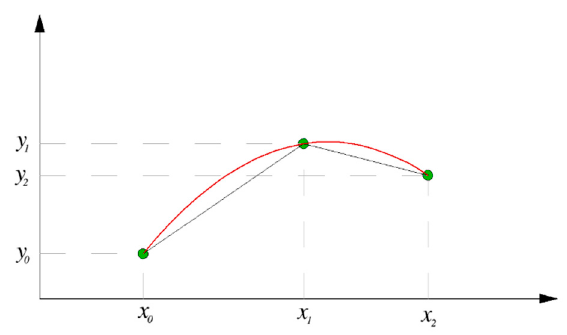
Figure 4. Lagrange interpolation by lines (black) and by a parabola (red). Inserting the values of the numerical example from Error! Reference source not found. into Error! Reference source not found. yields the Lagrangian form 0,2